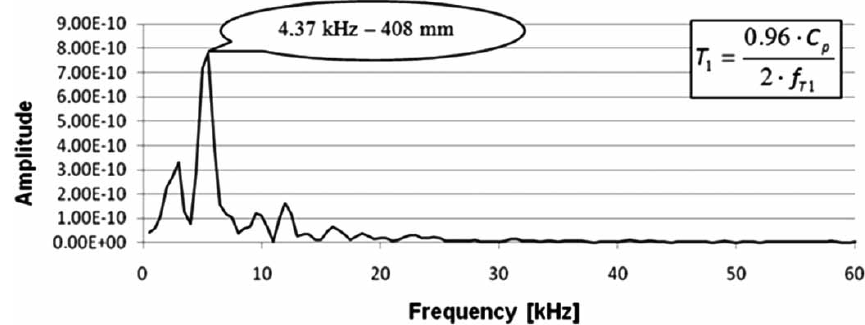
Fig. 12. Amplitude-frequency spectrum recorded in measuring place 7, using impact-echo